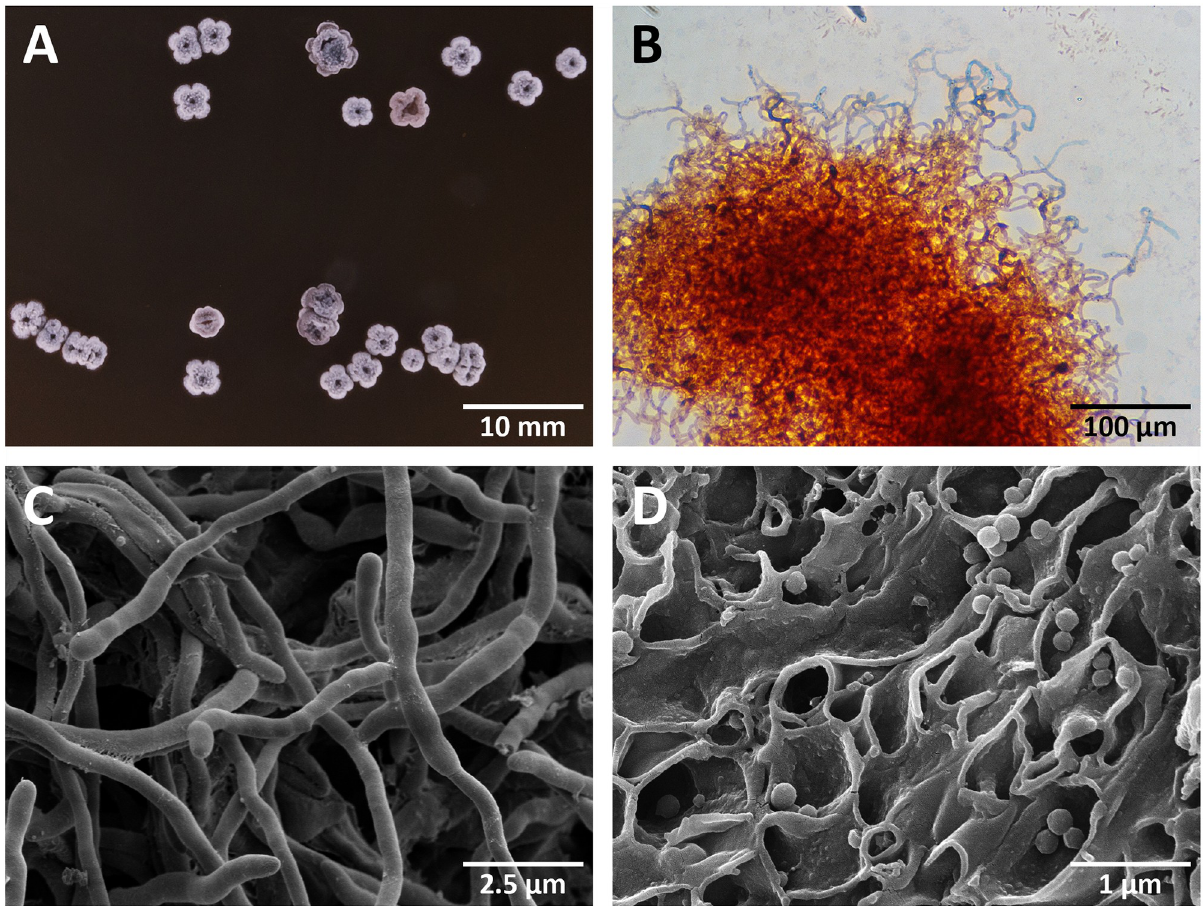
Fig 2. Photographic, light microscopy and electron microscopy images of Actinomadura sp. 32–07. After 21 days of growth on ISP medium 2, colonies are characterised by four major lobes, which often split in two minor sectors, and a central hollow pit (A, no magnification). Spore chains appear as long, flexuous series of subtle oval swelling stemming from a thinner, smooth hypha. Endospores inside the swellings can be viewed by light microscopy after staining with malachite green and counterstaining with safranin O (B, 100X magnification) or by closer inspection with electron microscopy (C, 8,500X magnification). Free spores of Actinomadura sp. 32–07 appear spherical and smooth, measuring 200–300 nm in diameter (D, 20,000X magnification).